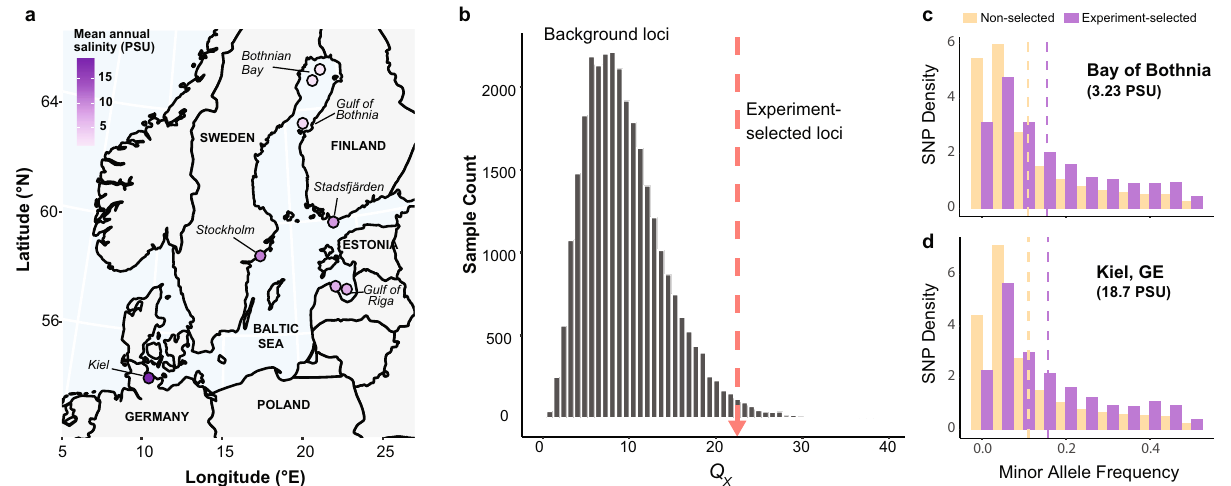
Fig. 3 Experiment-selected loci also exhibit signatures of selection in the wild populations from the Baltic Sea. a Locations sampled for pooled genomic sequencing across the Baltic Sea. Sampling sites are colored according to their mean annual salinity estimated from the International Council for the Exploration of the Sea (Supplementary Data 3). The map was generated using data from https://www.naturalearthdata.com (Accessed June 2020). b SNPs underlying experiment-selected alleles harbor a strong signature of polygenic selection across the wild populations, as captured by the Q X statistic. The Q X statistic measures how quickly the experiment-selected loci evolve and how strongly SNP frequencies covary across wild populations. The empirical Q X estimate for the experiment-selected SNPs (red dotted line) is far greater than the null distribution (gray histogram) based on the neutral population history and genomic background. c , d Minor allele frequencies (i.e., folded allele frequencies) for SNPs underlying experiment-selected alleles (purple) are signi fi cantly higher than non-selected SNPs (yellow) in two geographically divergent Baltic Sea populations from highly different salinity conditions. Vertical dotted lines display mean minor allele frequency for each category of